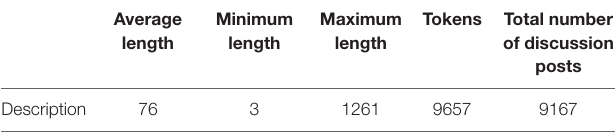
TABLE 1 | Description of the data set and summary statistics.